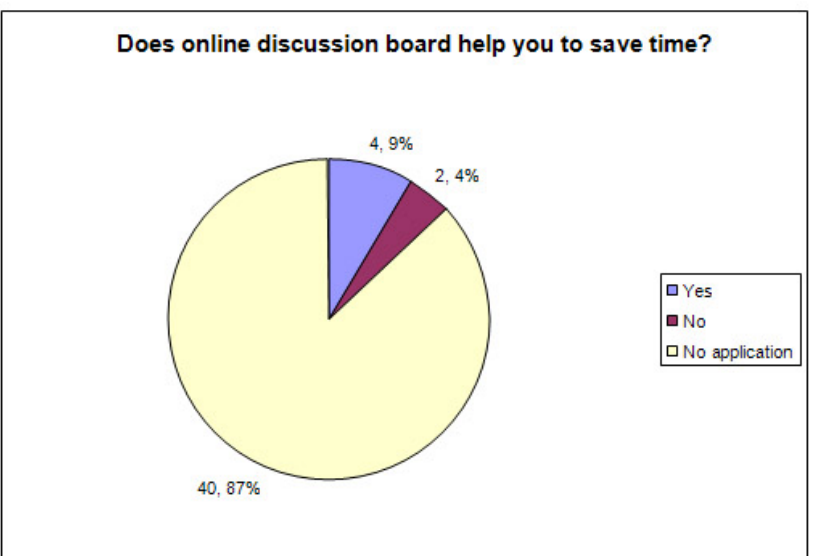
Figure 10. Mobile learning outcomes